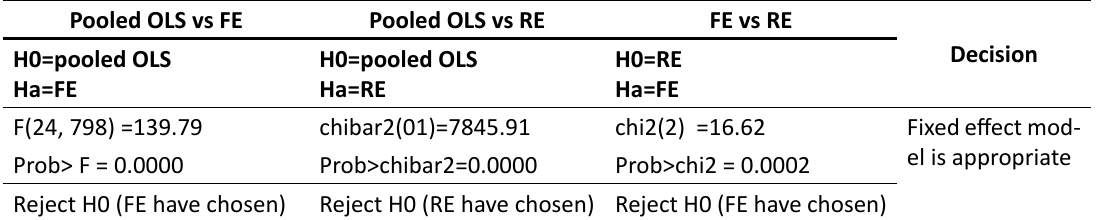
Table 4: Choosing the Appropriate Model To Test Kuznets